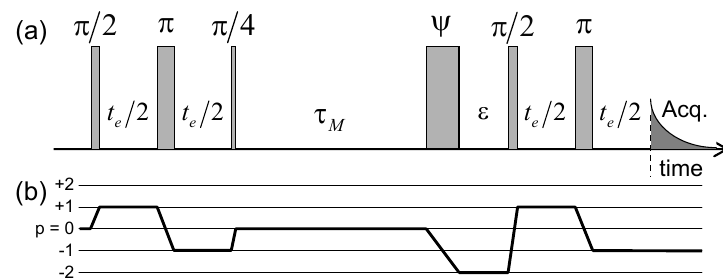
Figure 13. ( a ) Pulse sequence and ( b ) coherence pathway used to measure the attenuation of the two-time 2 H NMR stimulated echo I ( t e , τ M ) as a function of the evolution period t e and the mixing time τ M . Reprinted with permission from [53]. Copyright (2014) American Chemical Society.